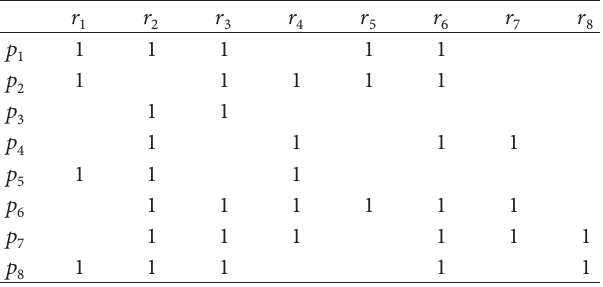
Table 4: A sample instance of projects covering